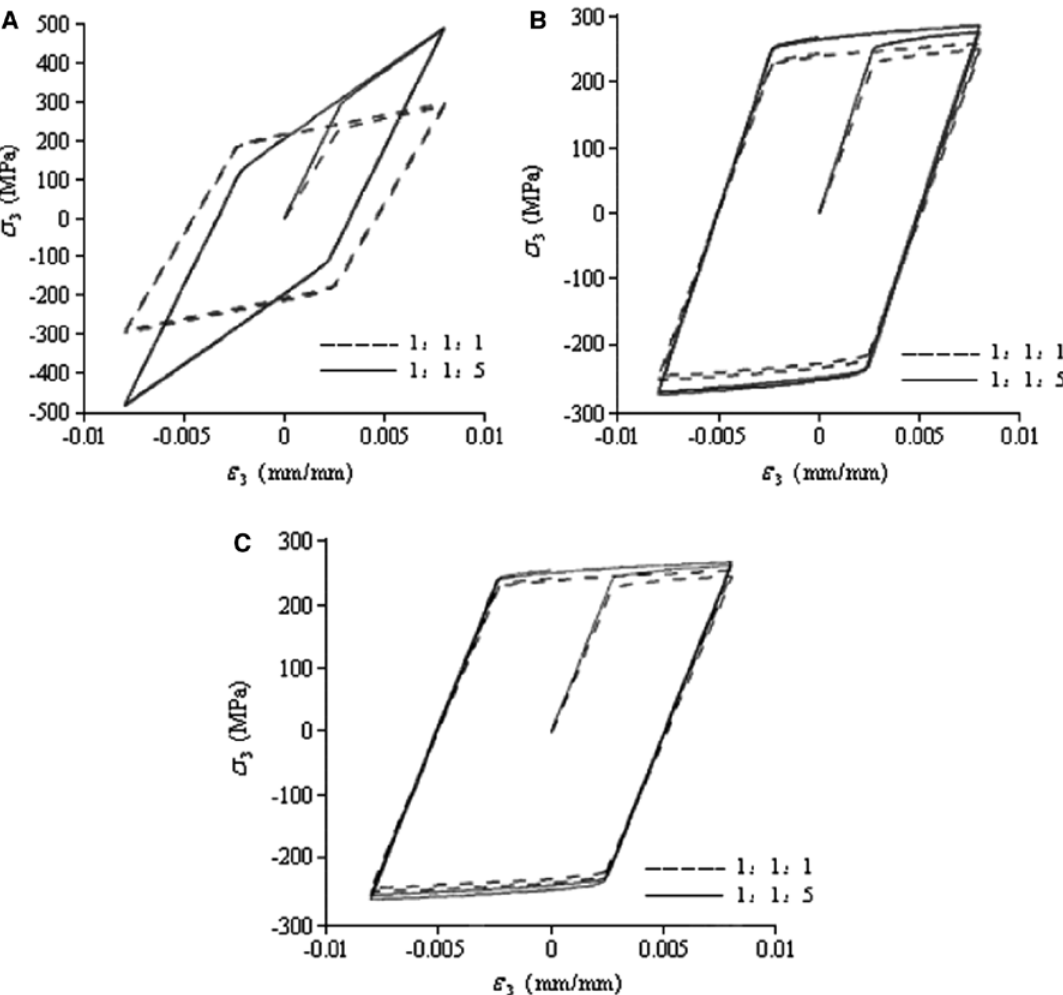
Figure 7: Stress-strain response of composite with different fiber aspect ratios: (A) unidirectional distribution, (B) cosine distribution, and (C) random